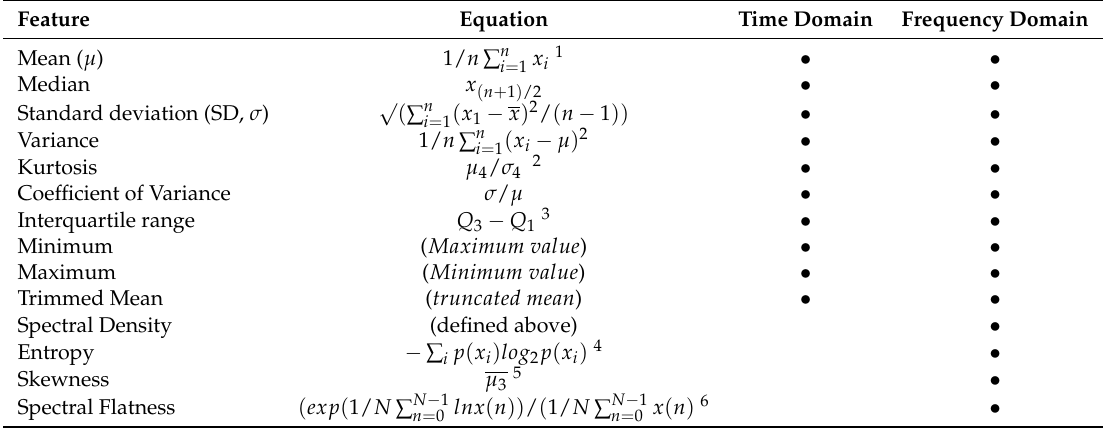
Table 2. Features extracted for the day, night and full day datasets, in time and frequency domain.